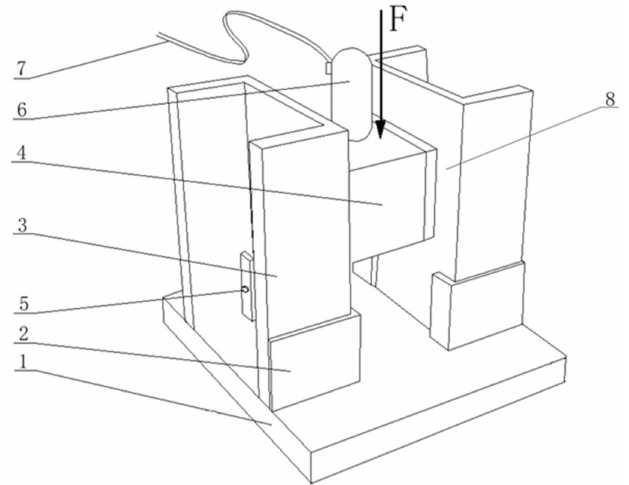
Figure 8. Spherical hinge waterproof coating consolidation strength test device. (1) Bottom plate; (2) positioning pieces; (3) steel splint; (4) concrete specimen; (5) positioning bolt; (6) indenter; (7) date transmission line; (8) waterproof